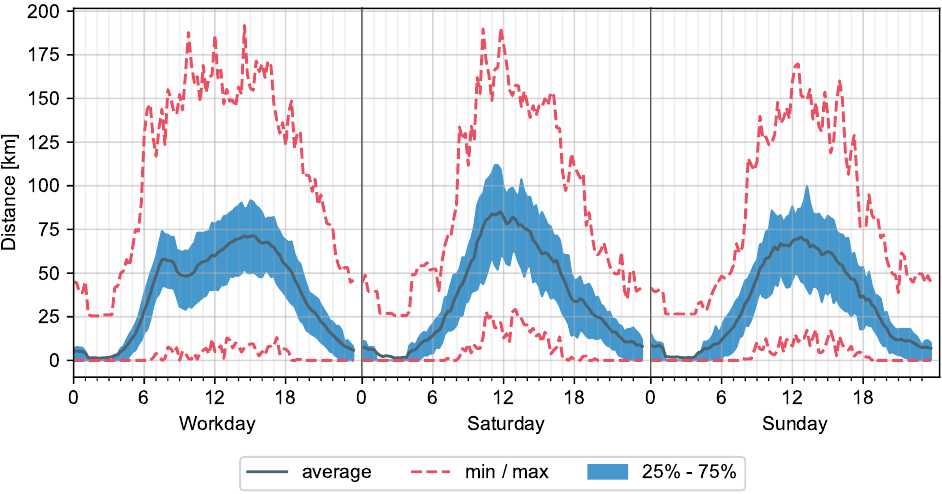
Figure 4. Daily driven distance of the aggregated EV driving profiles by day